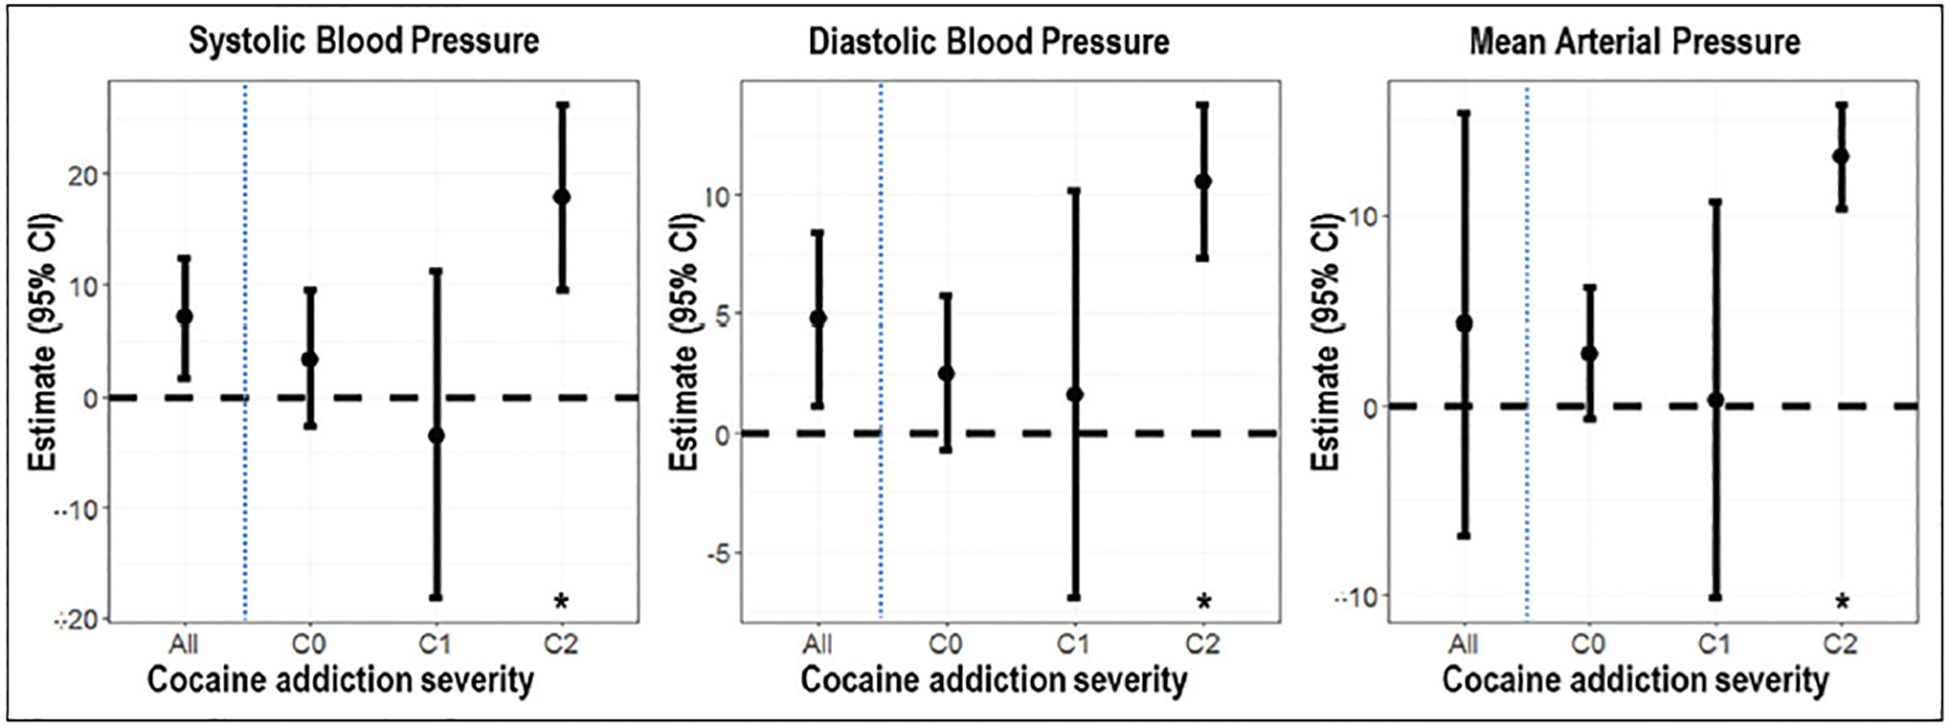
Tibia lead-blood pressure relationship and cocaine addiction severity as modifier of the relationship. Main effect of (log2-transformed) lifetime lead exposure on blood pressure levels and modifying effect of cocaine addiction severity on the relationship between bone lead (log2-transformed μg/g bone) and blood pressure levels. Cocaine addiction severity categories include all participants (All: main effect); nonusers (C0, reference), <44% lifetime use years (C1), >44% lifetime use (C2: square). 95% CI: 95% confidence interval; *P for interaction <0.05